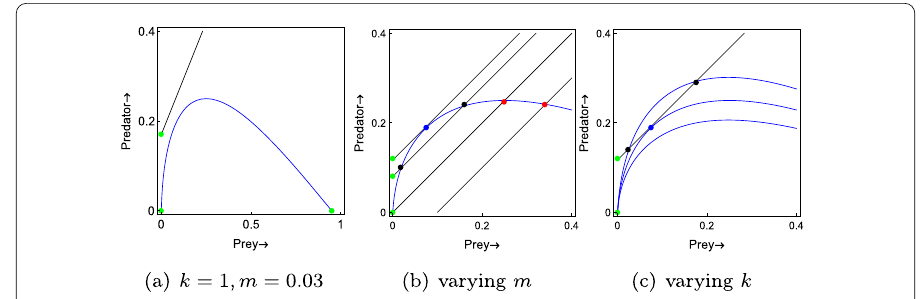
Figure 1 The blue line represents prey nullcline and the black line represents predator nullcline, ( a ) when k = 1, m = 0.03, there is no interior equilibrium point. ( b ) Fixing k = 1 and varying m shows that system (2.4a)–(2.4b) has a unique equilibrium E 1 in blue dot, two interior equilibria E 2 , E 3 in black dot, one equilibrium E 3 coincides with E 0 and has a unique interior equilibrium E 4 in red dot for m = c , E 3 disappears and E 5 is given in red dot for m > c . ( c ) Taking m = 0.08586, the scenario for the existence of no equilibria, unique equilibrium, and two equilibria by varying fear parameter k